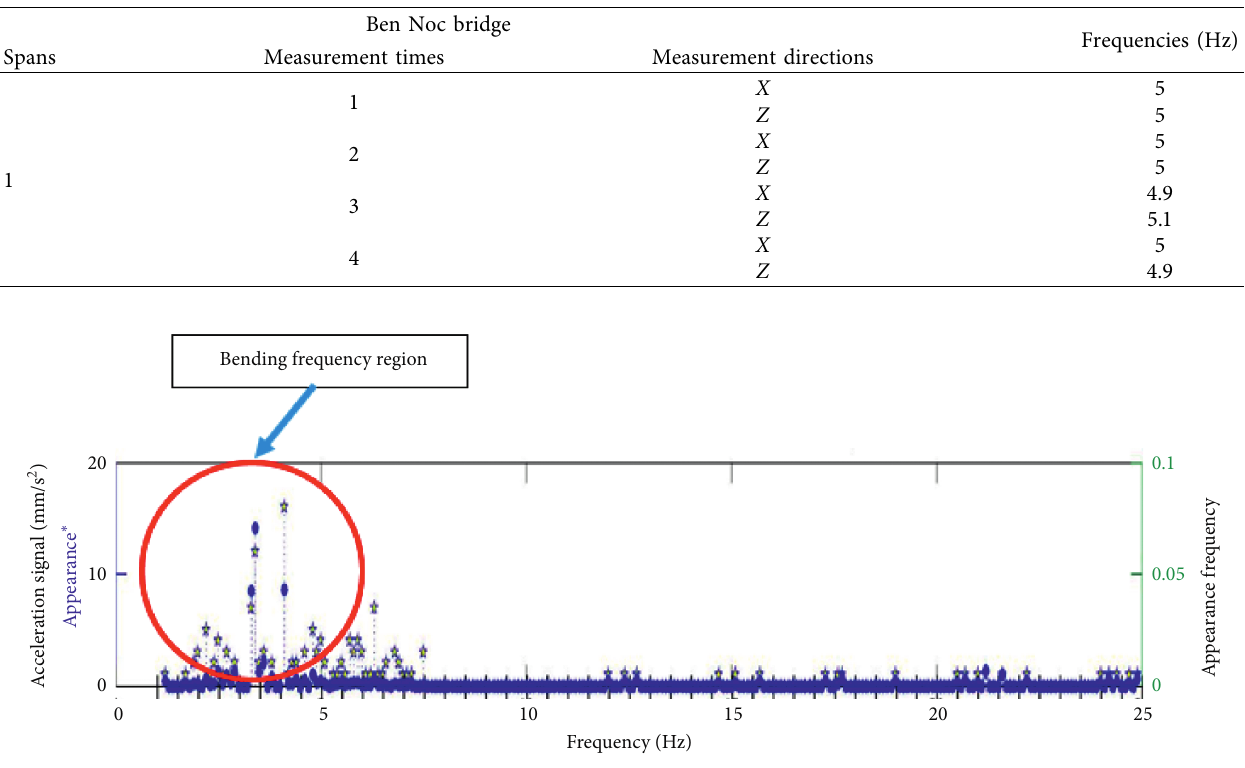
z of Ben Noc bridge.